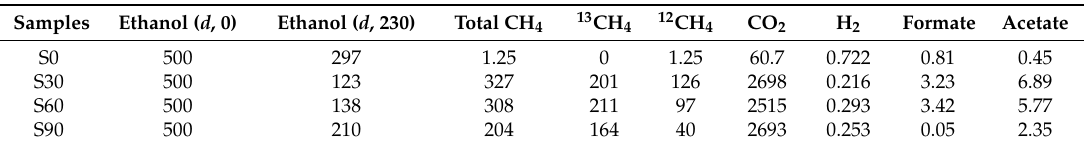
Table 1. Metabolites ( µ mol/bottle) detected in different treatments after anaerobic incubation